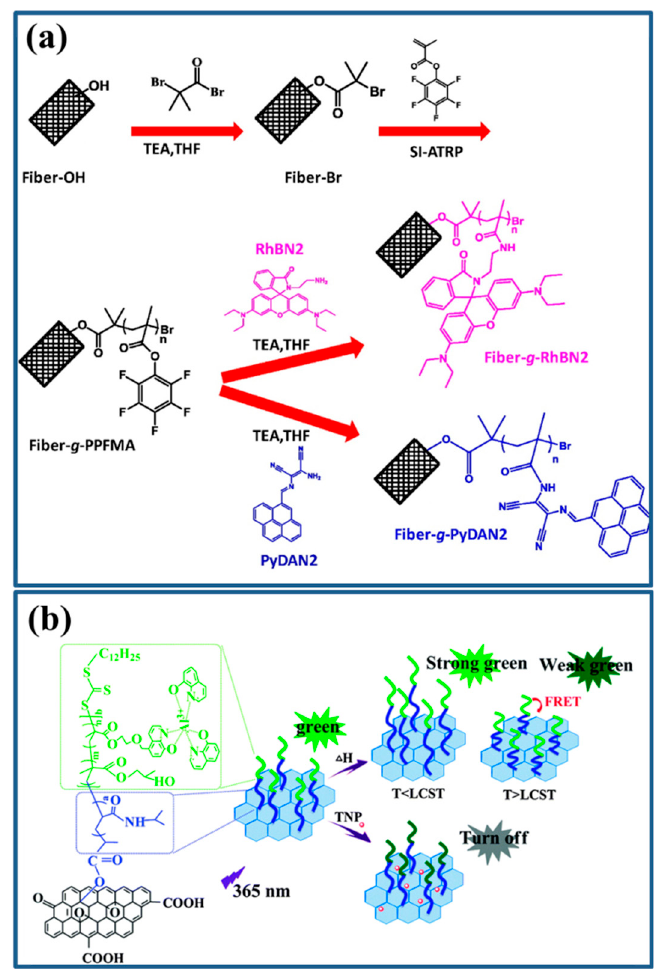
Figure 4. ( a ) Surface initiated atom transfer radical polymerization(ATRP) process establishing the grafting process b/w copolymer and chromophore groups. Adapted from work in [100] with permission from Elsevier. ( b ) Block copolymer brush generated using Reversible addition fragmentation chain transfer (RAFT) and successive grafting harvests the turn off fluorescence in response to 2,4,6-trinitrophenol (TNP) and exhibits thermoresponsive character. Reprinted from work in [101] with permission from Royal Society of Chemistry.